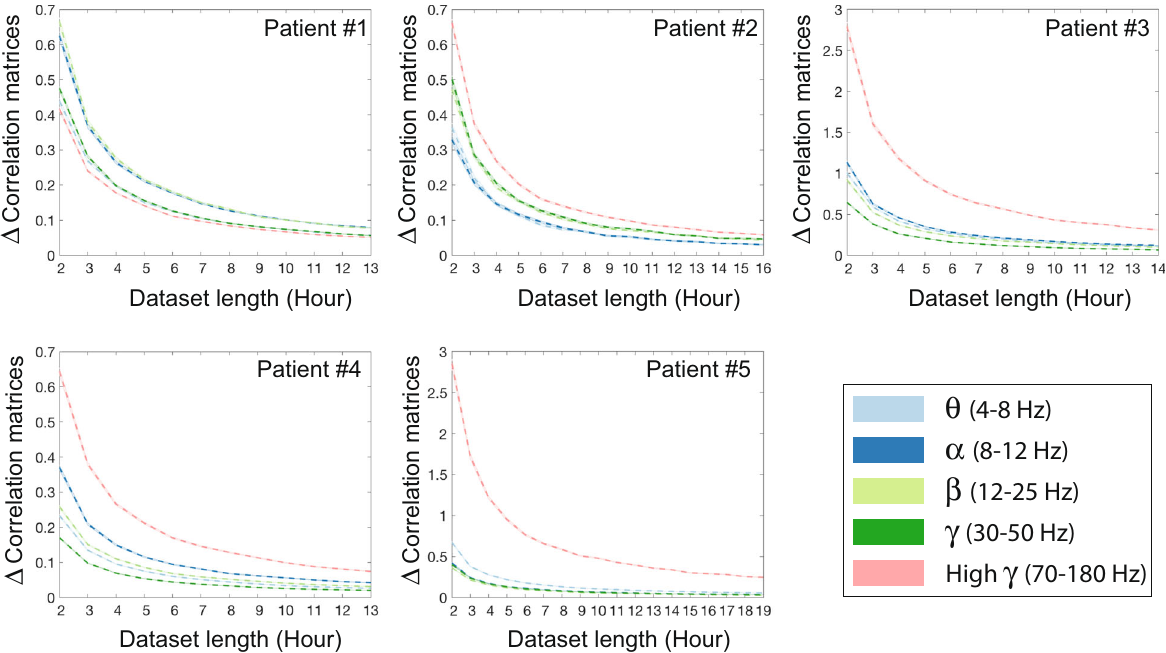
Fig. 2 The relationship between length of dataset and stability of pairwise correlations. Plots show the mean (10,000 iterations) difference between the two correlation matrices calculated from randomly selected (1-h inter-ictal segments) datasets with lengths of n and n − 1 hours. We use the matrix norm to quantify the difference between correlations matrices. The shaded-area around the means (dashed line) highlights the standard error, and colors indicate the frequency bands.